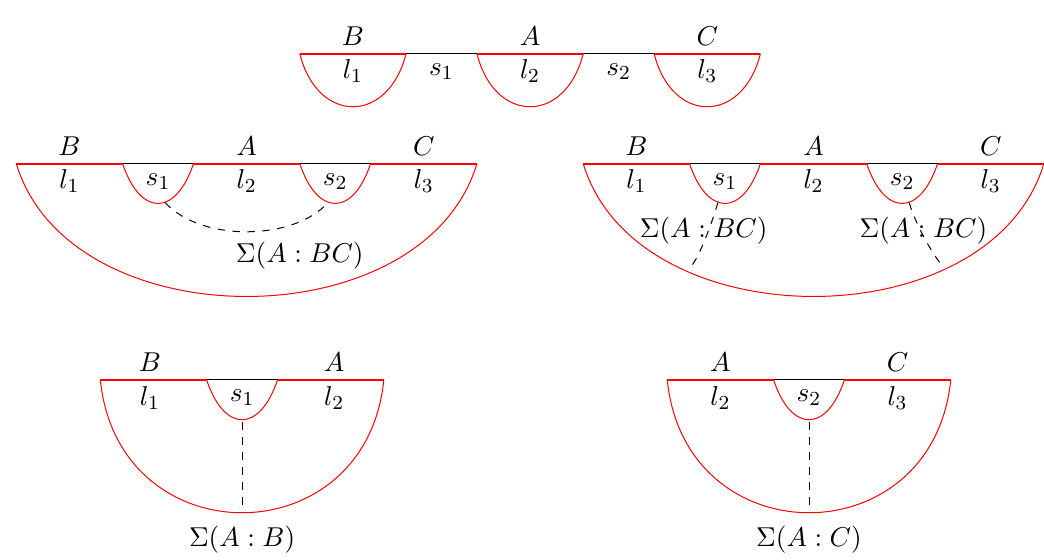
Figure 4 . Pictorial representations of the configurations in S A and S B phases for the case of three disjoint intervals with subsystem A in the middle. Top row : the tripartite configuration in the S A phase. No EWCSs exist in this case. Middle row : the tripartite configuration in the S phase. The B EWCS is obtained through the area of the Σ( A : BC ) (dashed curves) either from the standard single component configuration (left) or the double component configuration (right). Bottom row : bipartite configurations in the S phase. The dashed curves in the left and right plots represent B Σ( A : B ) and Σ( A : C ) ,